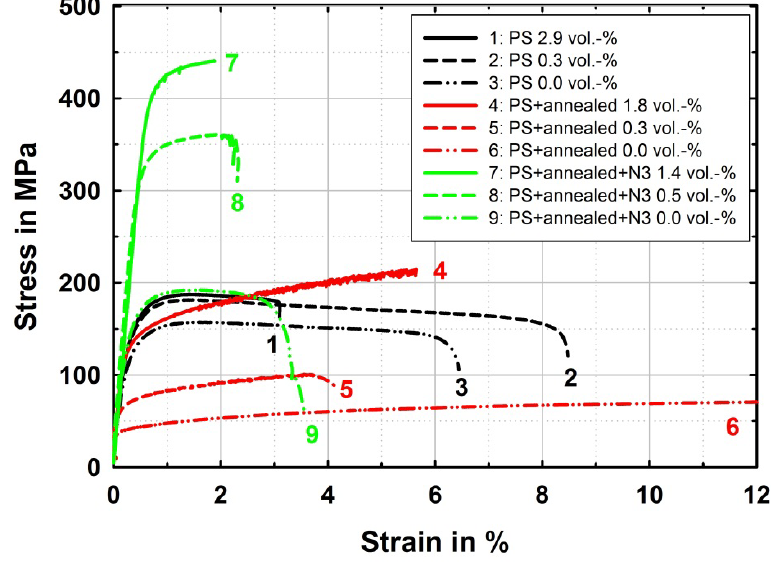
Figure 3. Stress-strain data of AA1050A reinforced with different selected amounts of copper particles in different microstructural states: Particle strengthened after nine ARB cycles (PS), solution annealed in a further process step (PS + annealed) and after further three ARB cycles (PS + annealed +